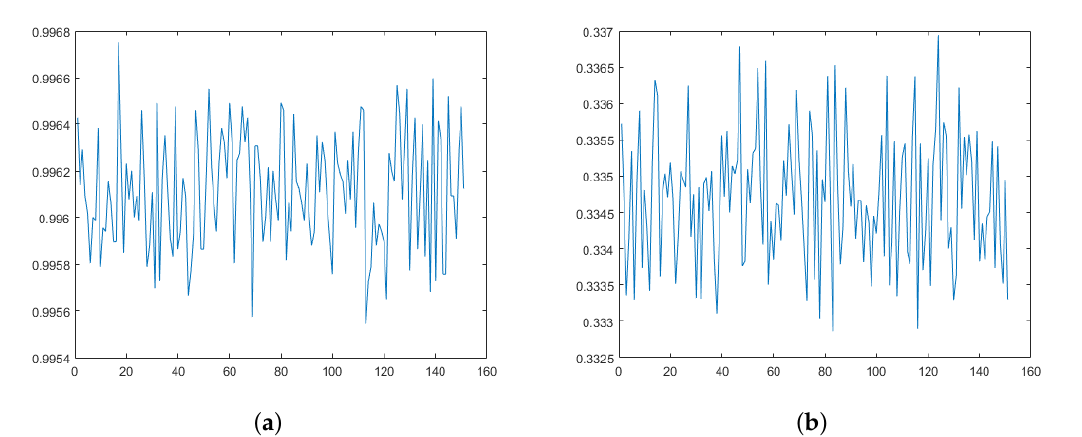
Figure 14. Values of NPCR and UACI of 150 images with one bit changed. ( a ) NPCR ( b )